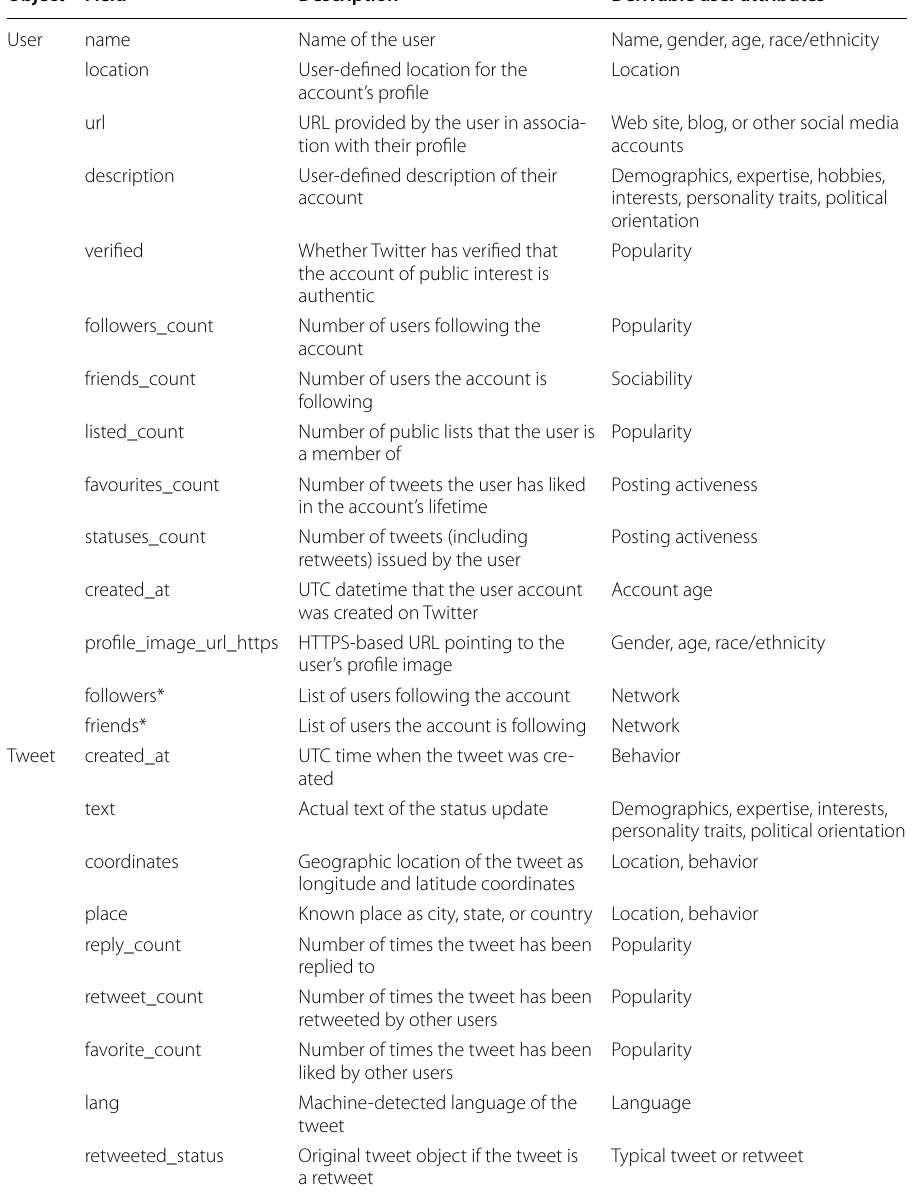
Table 2 Summary of the user attributes derivable from native Twitter objects Object